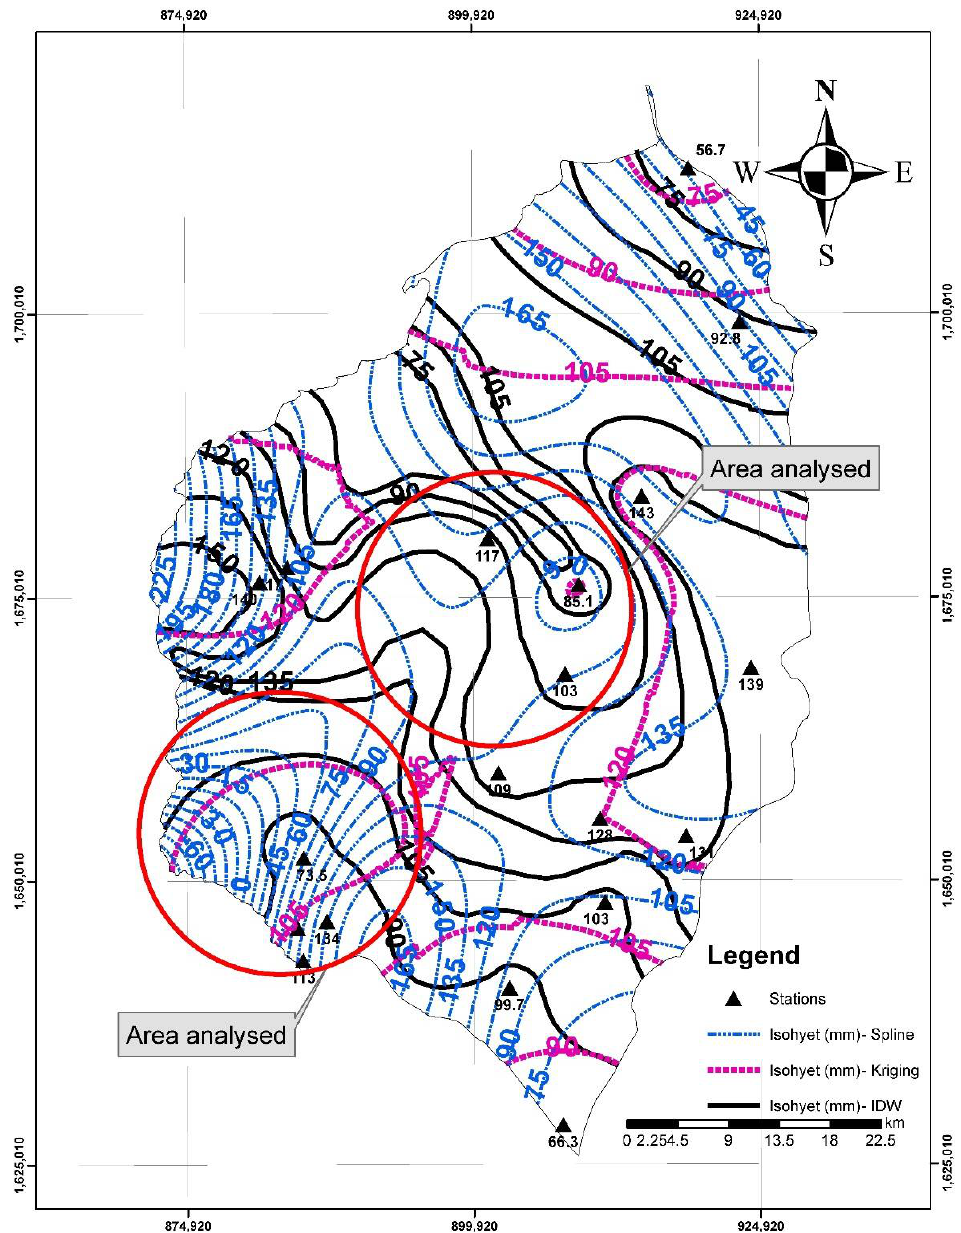
Figure 3. Comparison of spatial interpolation methods. Spatial distribution of P prior-5d for a 100-year RP by using spline, kriging and IDW method.